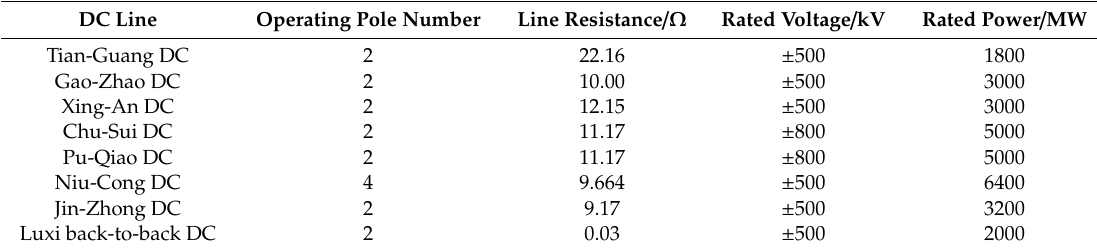
Figure 3. Total power exchange schedule curve of each provincial power grid and the external networks. Table 1. Basic characteristic parameters of the DC transmission lines.